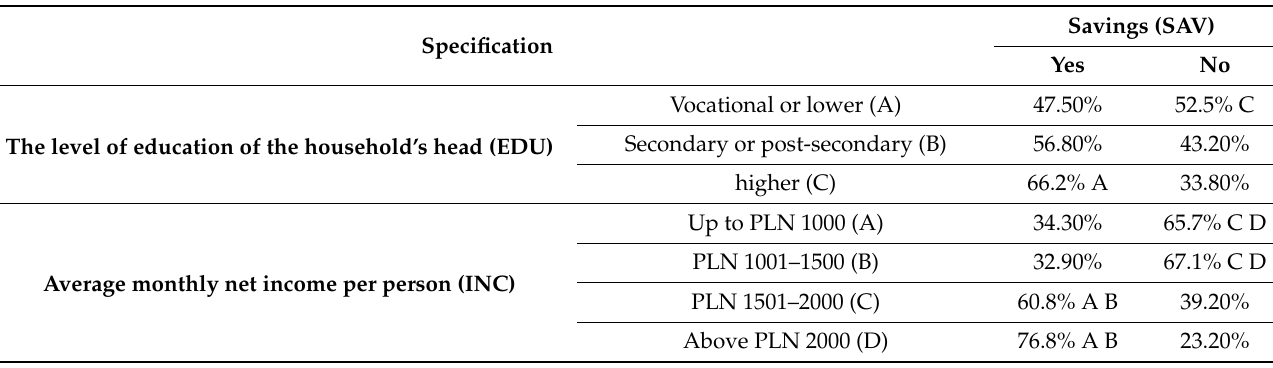
Table 3. Accumulation of savings and selected characteristics of the surveyed agricultural households ( n = 191).